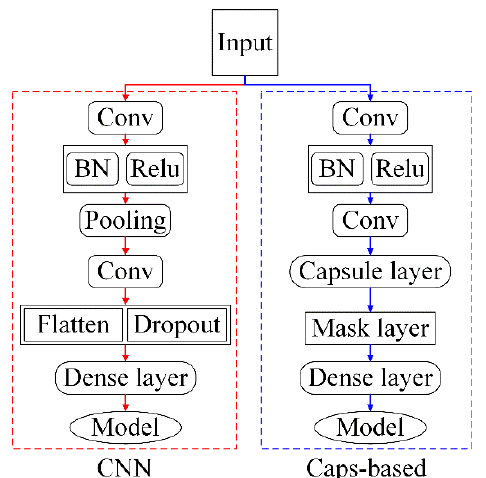
Figure 6. The network architectures of 1DCNN, CNN, 3DCNN, Caps, Acaps, and PAR-ACaps. The red lines with an arrow represent the data flows in the CNN-based models. In comparison, the blue lines denote the data flows in the Caps-based models.